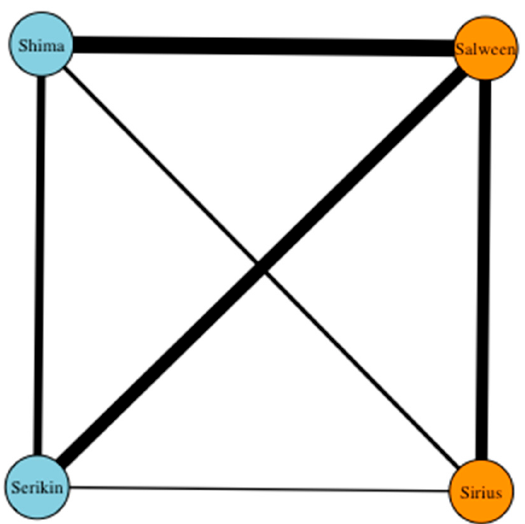
Figure 5. Behavioral category frequency for social interactions between the male (Sirius) tiger and the two cubs (Serikin and Shima) (undirected) at Parc des Félins.